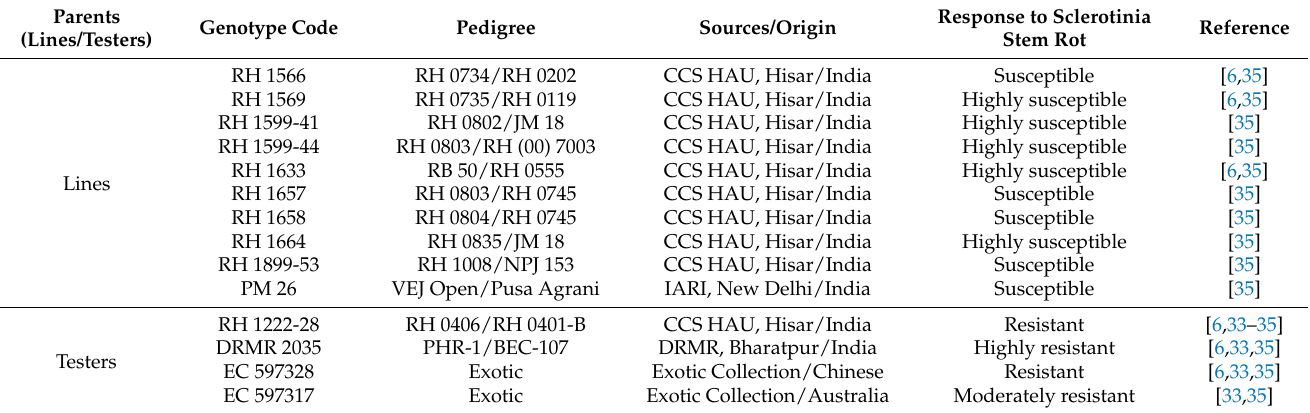
Table 1. List of parental lines used in the present investigation along with their pedigree, source/origin, and their response towards Sclerotinia stem